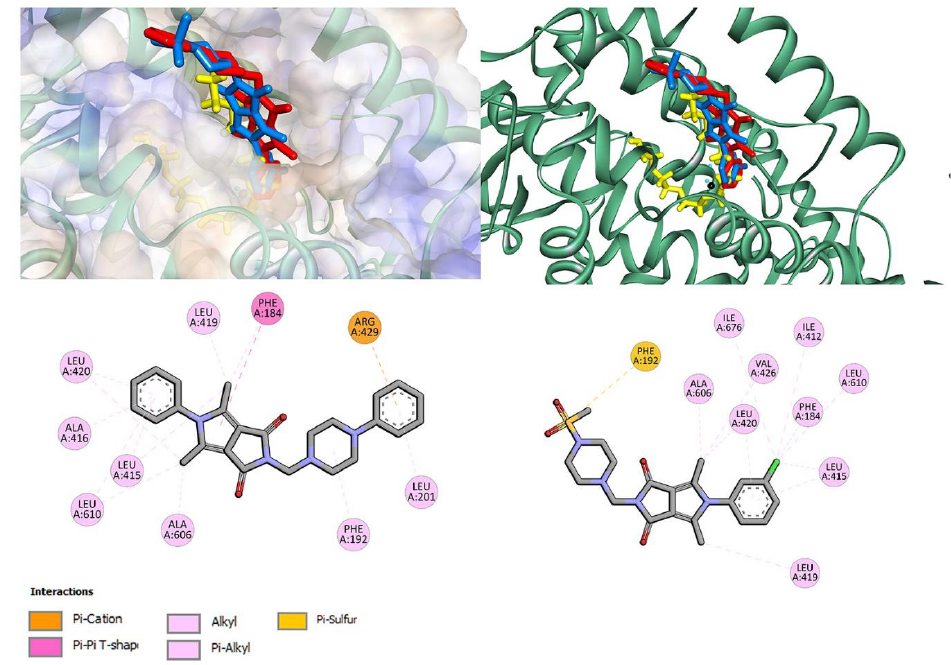
Figure 2. The docked pose of 7a (red), 7n (blue) into the active pocket site of 15-lipoxygenase (15-LOX) with substrate mimic inhibitor (yellow) and 2D interaction plot ( 7a — left , 7n — right ).